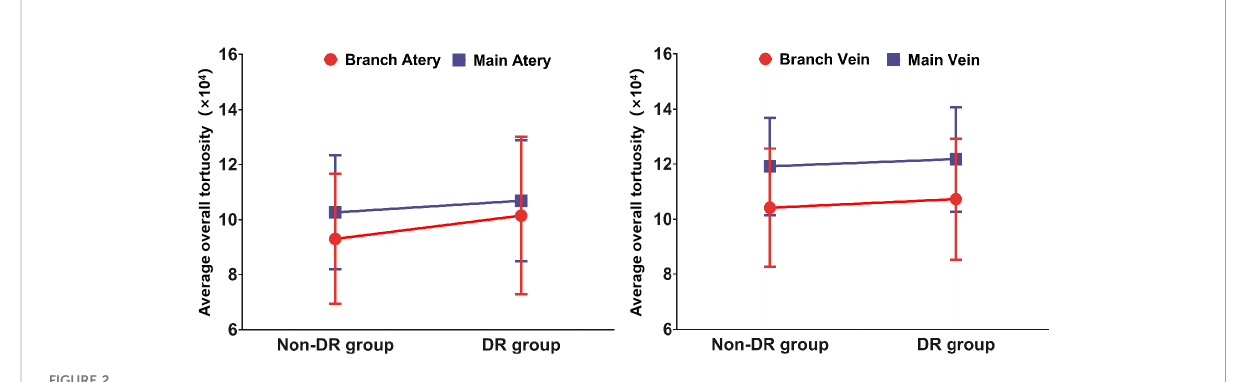
FIGURE 2 The relationship between retinal vascular tortuosity and DR